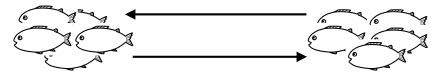
Fig. 13. Four-cell networks that admit three-cell bidirectional ring as a quotient, taken from [1]